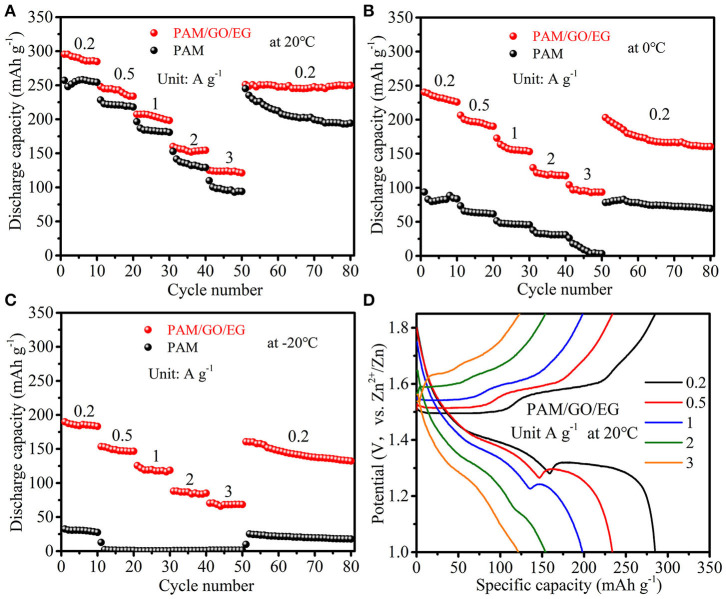
Rate performances of Zn-MnO2 batteries with PAM/GO/EG and PAM gel electrolytes: (A) at 20°C, (B) at 0°C, and (C) at −20°C. (D) GCD curves of Zn-MnO2 battery with PAM/GO/EG at 20°C.